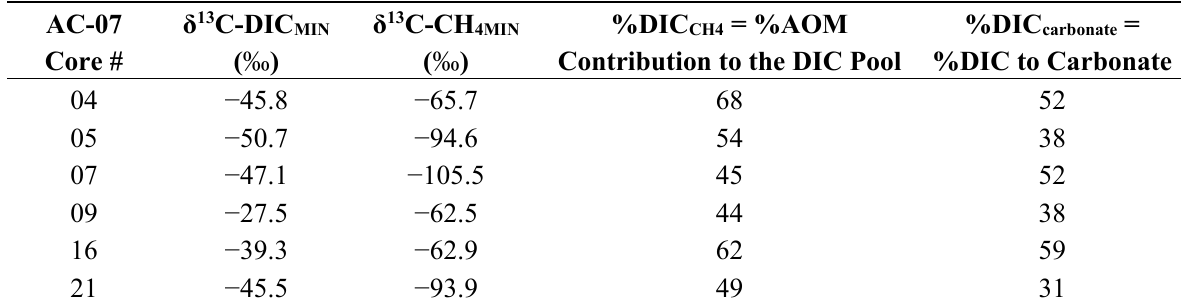
Table 3. Estimates of percent contribution of AOM to the DIC pool and the percent contribution of the DIC pool to solid phase carbonates at the SMT for the AC-07 piston cores (Table 2). The percent contribution of AOM to the DIC pool was based on a mass balance using the minimum measured δ 13 C-DIC and δ 13 C-CH 4 value near the base of cores where the SMT was not present and from the estimated depth of the SMT where it was